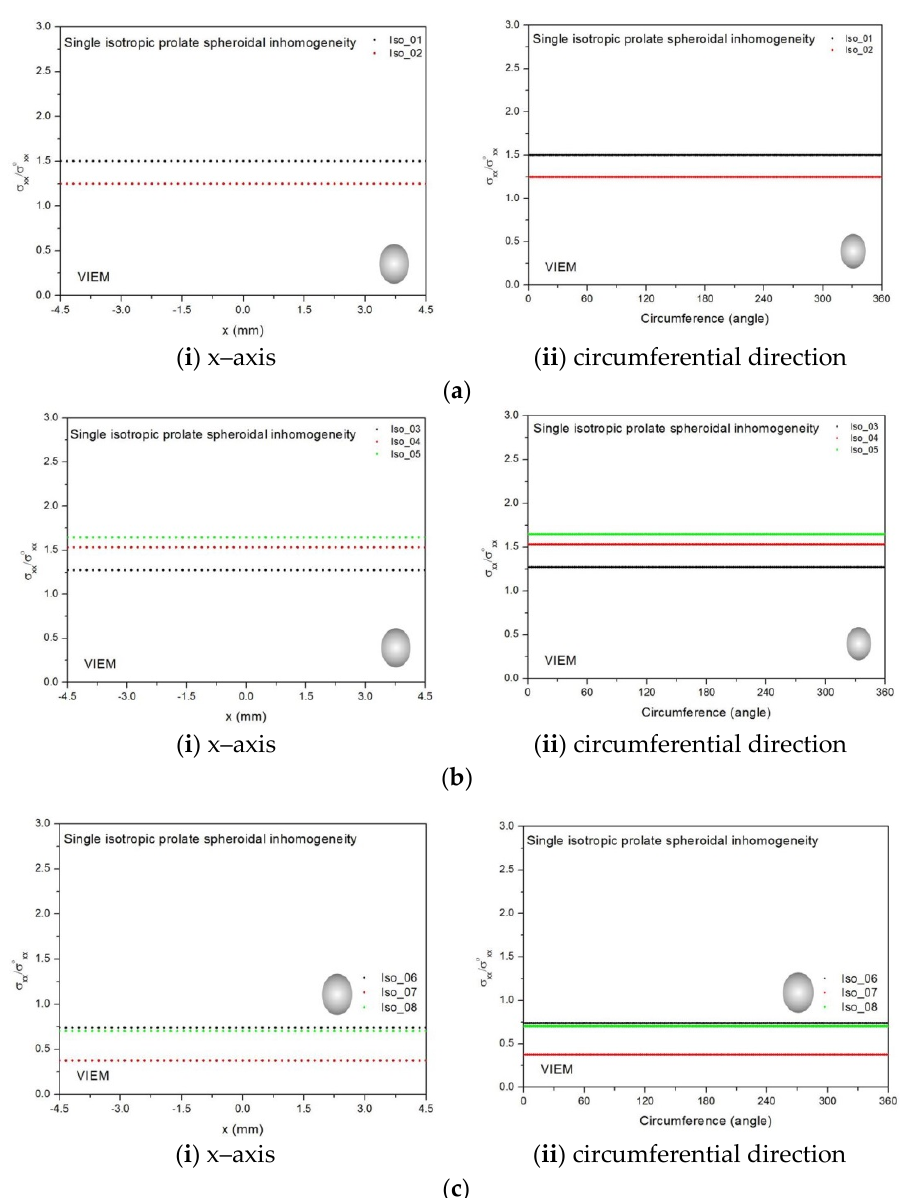
Figure 12. VIEM results for the normalized tensile stress component ( σ xx / σ oxx ) along ( i ) the x–axis inside and ( ii ) the circumferential direction of the isotropic prolate spheroidal inclusions with a/b = c/b = 0.5 (b = 6 mm) under uniform remote tensile loading. ( a ) Iso_01 and Iso_02. ( b ) Iso_03, Iso_04 and Iso_05. ( c ) Iso_06, Iso_07 and Iso_08.